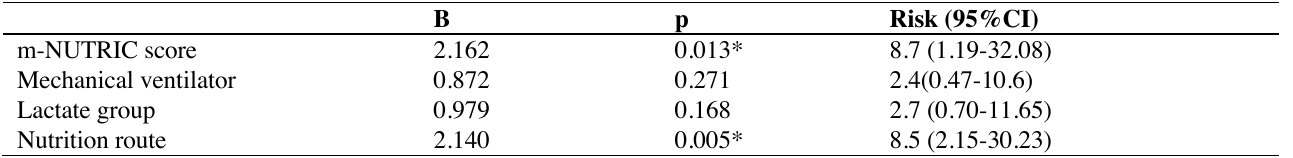
Table 3. Multiple logistic regression models for variables with p<0.05